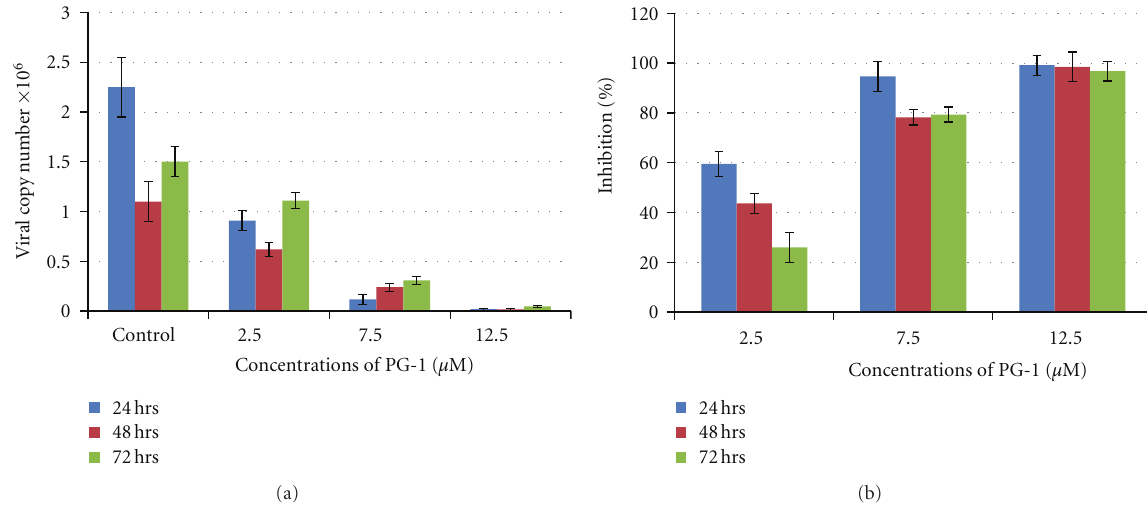
Figure 5: RNA quantification and the percentage of inhibition after applying di ff erent concentrations of PG-1 on MK2 cell lines infected with dengue virus. The standard curve was generated by 10-fold serial dilution of known copies of dengue RNA. Viral RNA was extracted from cellular supernatant and the fragment located at the 5 (cid:3) UTR region of the virus genome was amplified using one-step RT-PCR. Significant reduction ( P < 0.001) in viral copy number was observed with increasing PG-1 concentration (a). The highest inhibition percentage was observed with 12.5 μ M at 24, 48, and 72hrs (b). PG-1 significantly ( P < 0.01) inhibited DENV-2 replication in a dosedependent manner with the greatest inhibition e ff ects at 24 hrs (two-way ANOVA with Bonferroni posttest, mean ±